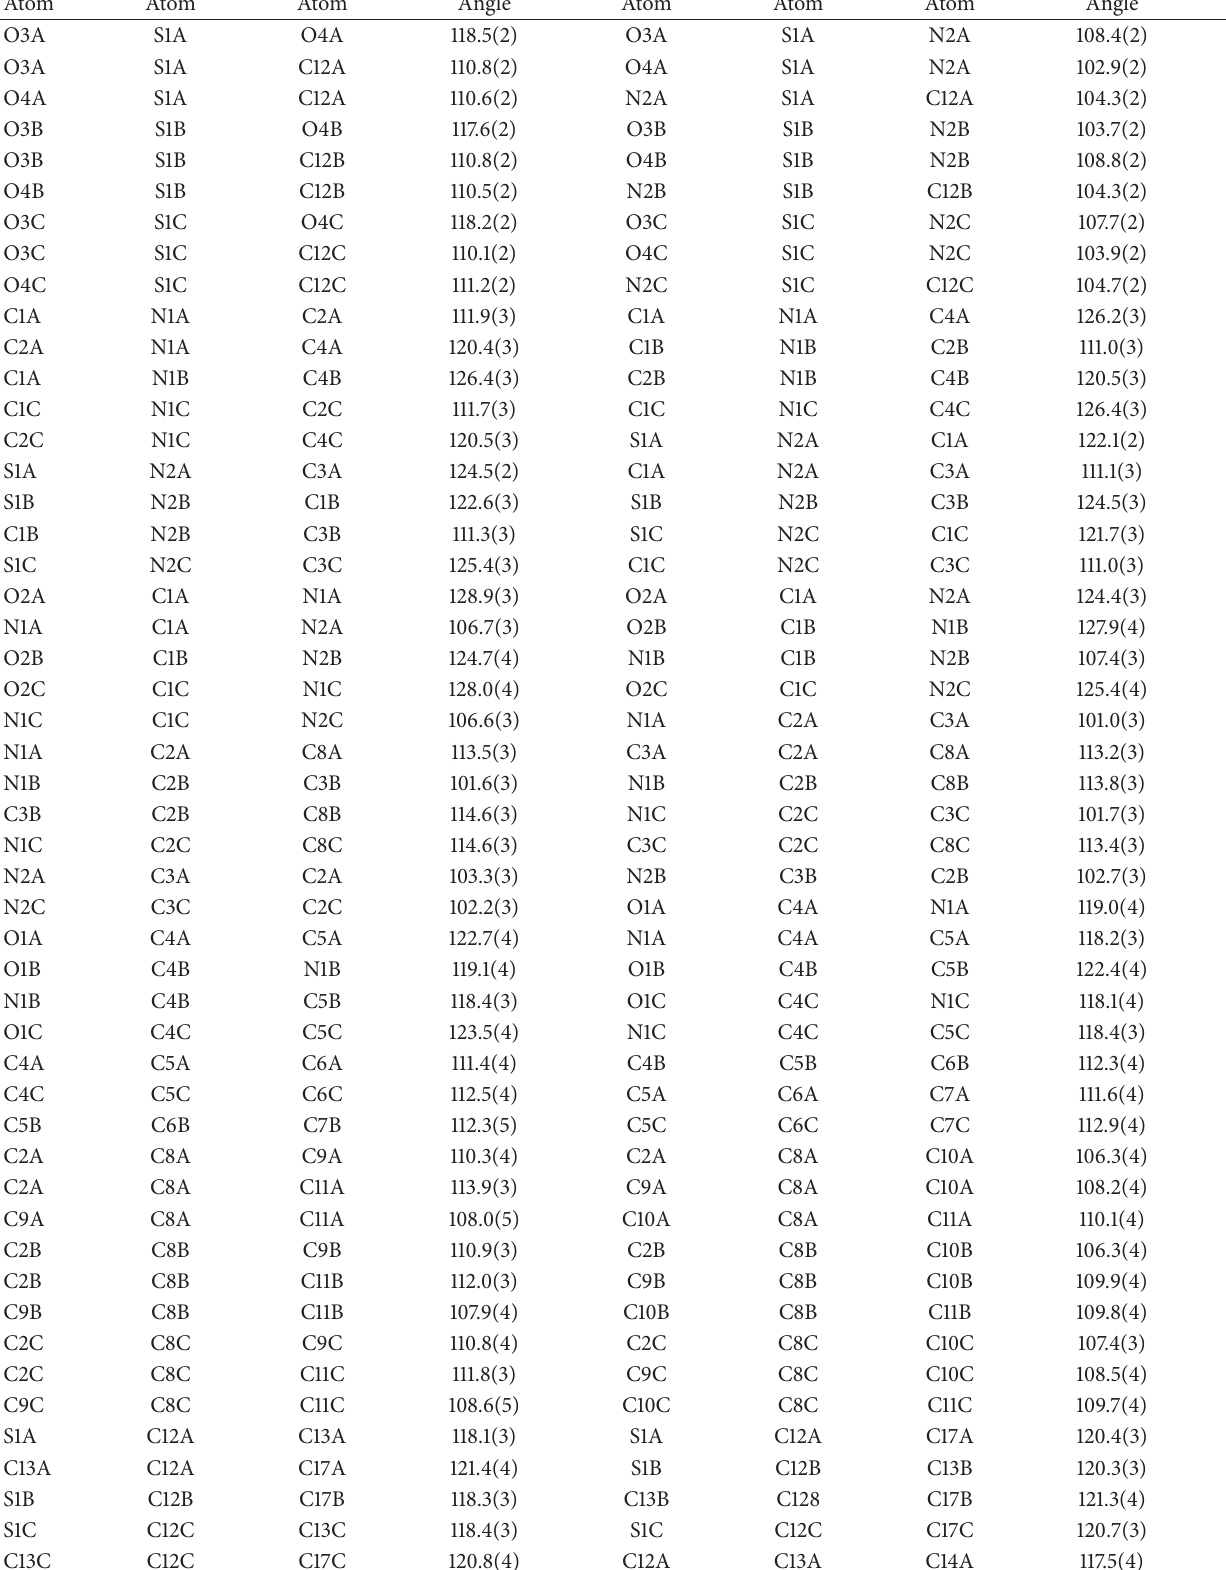
Table 3: Experimental bond angles